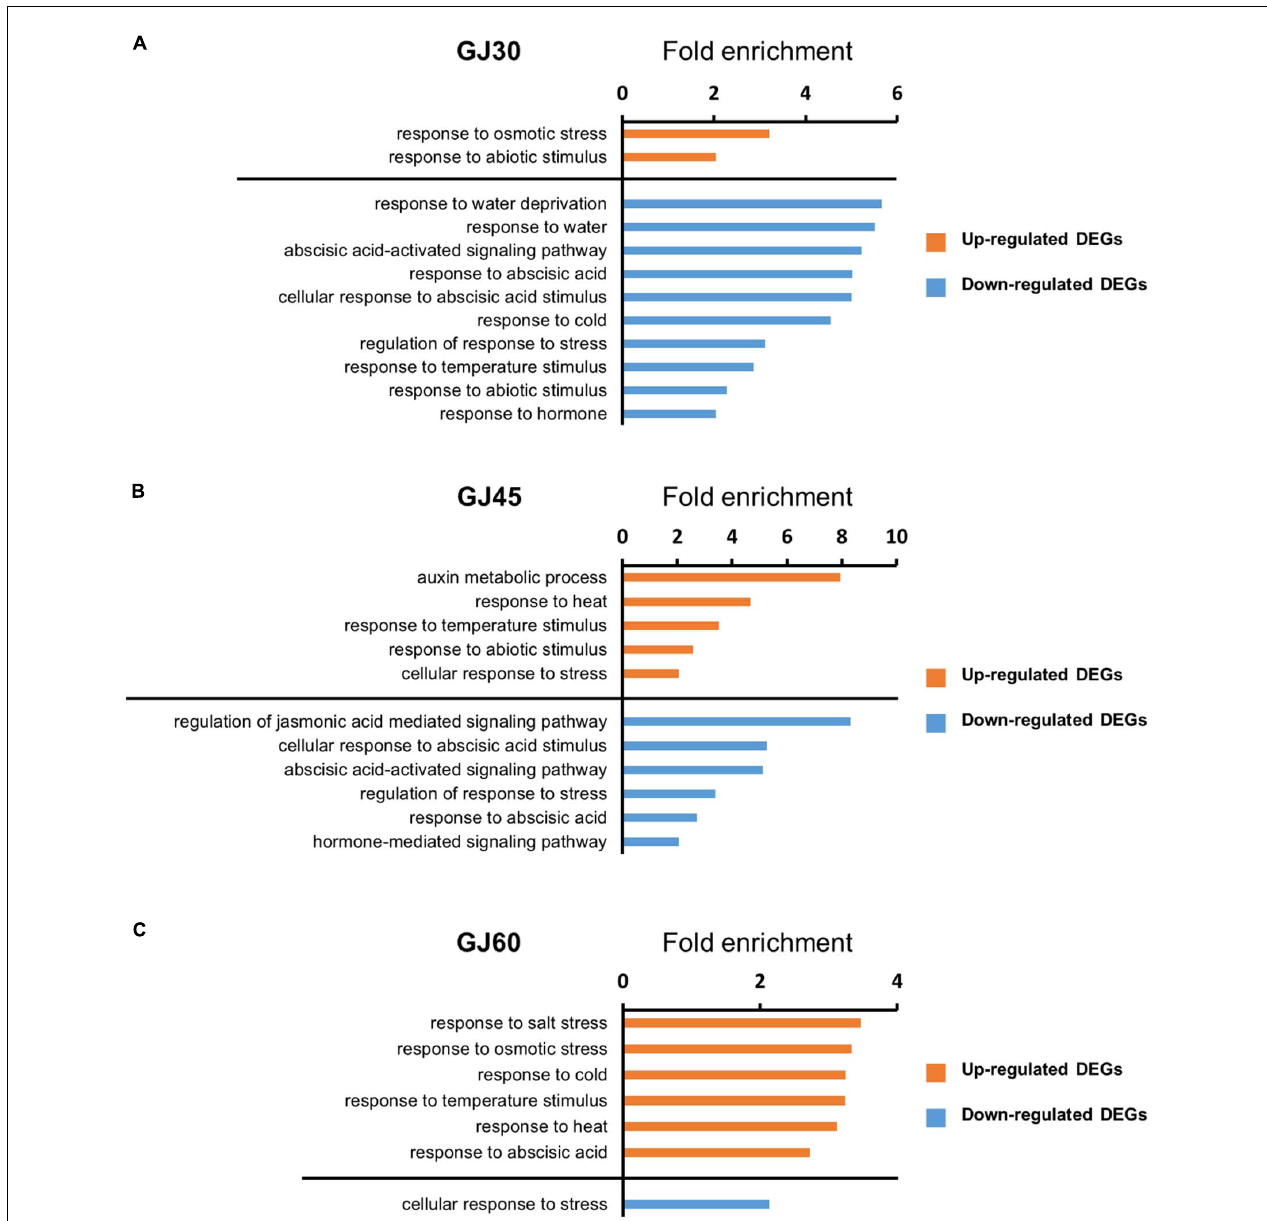
FIGURE 3 | Gene ontology (GO) enrichment analysis of differentially expressed genes (DEGs) identified in the embryo in the biological process category. (A–C) GO terms (fold enrichment > 2 and false discovery rate < 0.05) of DEGs, which were up- or down-regulated in Jowoon compared with those in Gopum, related to hormones and abiotic stress in the embryo of GJ30 (A) , GJ45 (B) , and GJ60 (C) .